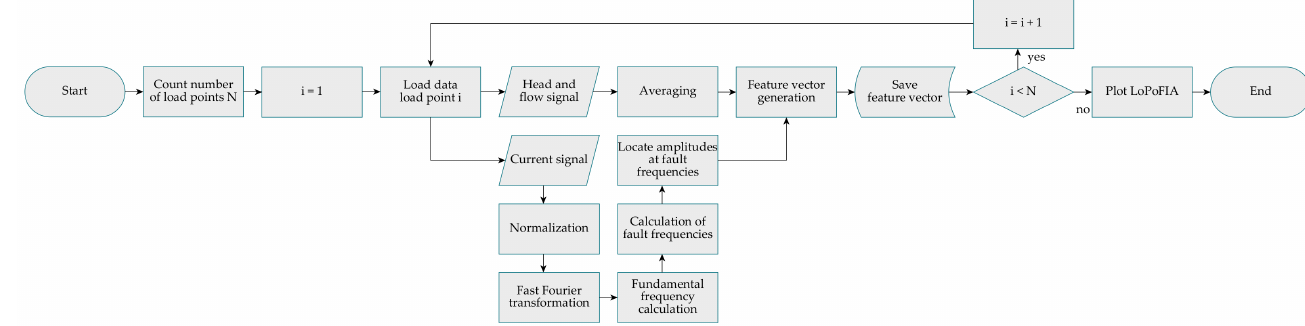
Figure 2. Flow chart of the implementation of the LoPoFIA.